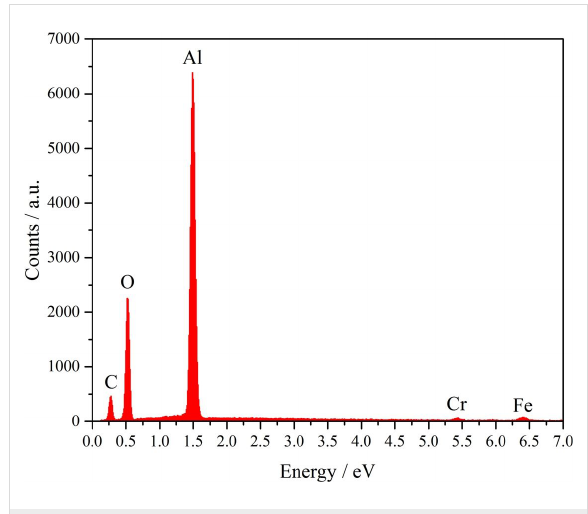
Figure 11: EDX spectrum of CNWs on stainless steel (Fe, Cr). Besides carbon and aluminium, oxygen can be found in the